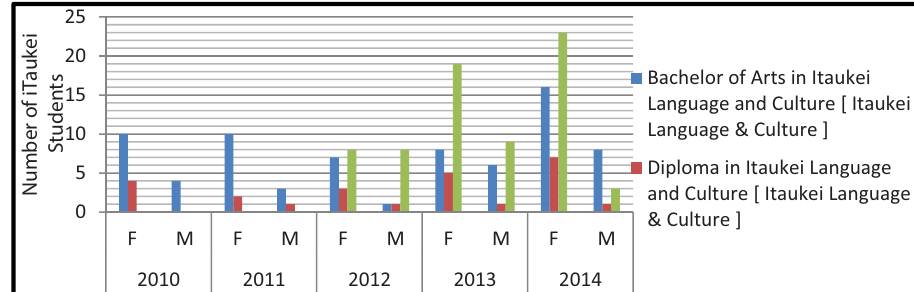
(Colour online) Student enrolments as per gender and